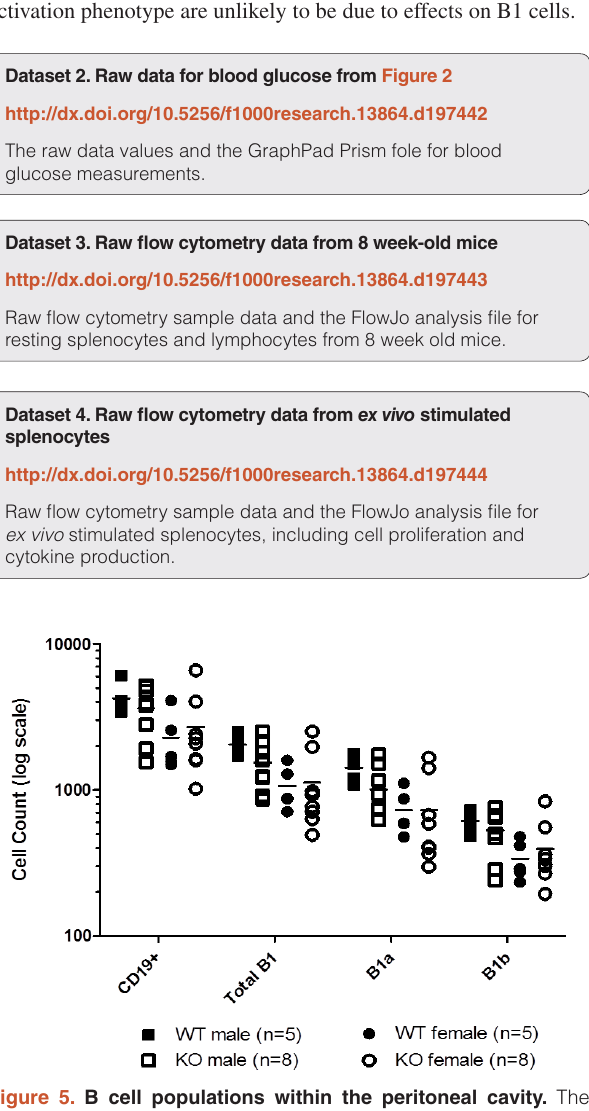
Figure 5. B cell populations within the peritoneal cavity. The number of B cells in the peritoneal cavity of 4 week-old mice were measured, including all CD19 + cells, all B1 cells, and the subpopulations of B1a and B1b cells. The data were combined from two independent